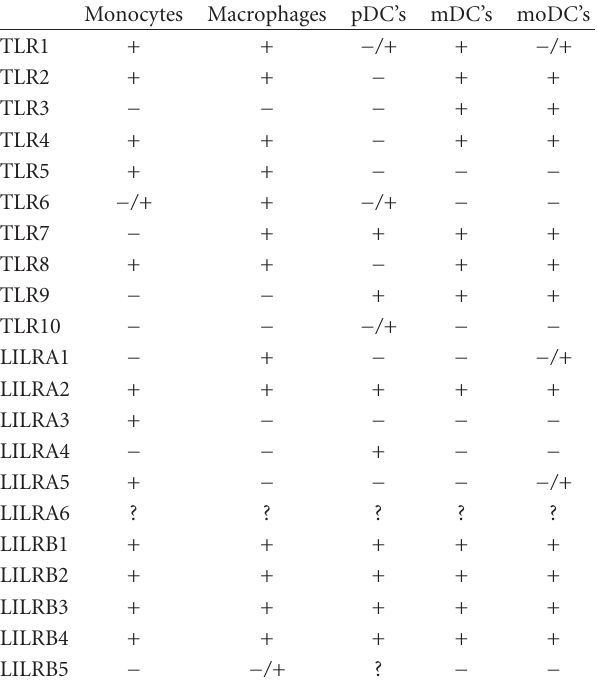
Table 1: Expression profile of TLR and LILR on di ff erent APC subsets: this table depicts the known expression levels of TLRs and LILR on subsets of APCs. + denotes high expression, − / + denotes weak expression, and − is no expression. ? is used where expression levels are yet to be determined [5–14].